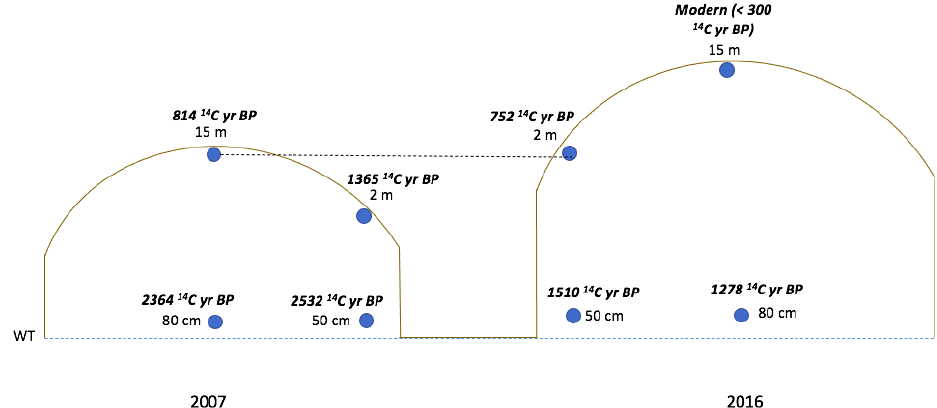
Figure 8. Incubation sampling locations with respective 14 C ages (all depths approximate). The horizontal line is drawn to show that these elevations are approximately